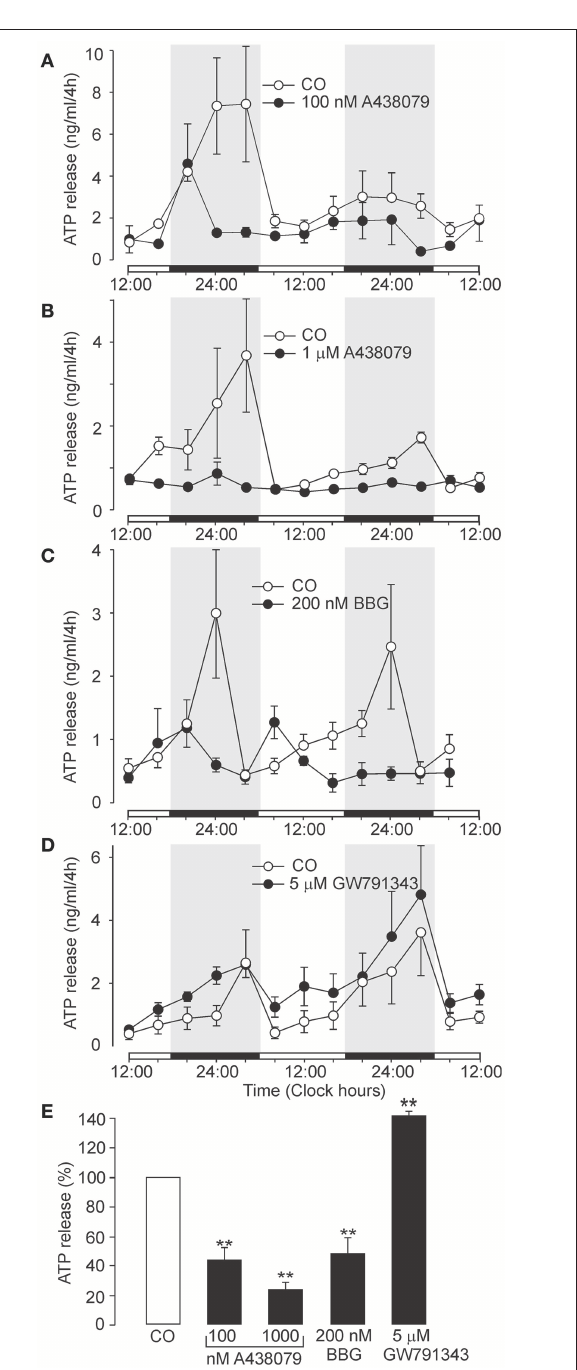
FIGURE 3 | Inhibition of circadian ATP release by the selective P2X7R inhibitors A438079 and BBG, and potentiation by positive allosteric modulator GW791343. (A–D) Examples of the ATP release rhythm in control cultures (open symbols) and cultures treated with selective P2X7R modulators (closed symbols). Inhibitory effects of 100nM A438079 (A) , 1 µ M A438079 (B) , and 200nM BBG (C) , and potentiating effect of the positive allosteric modulator GW791343 at 5 µ M concentration (D) . Summary graph comparing the effects of positive and negative modulators on cumulated ATP (E) . Data are presented as the means ± SEM of three to seven experiments. ** P < 0.01 as compared to the